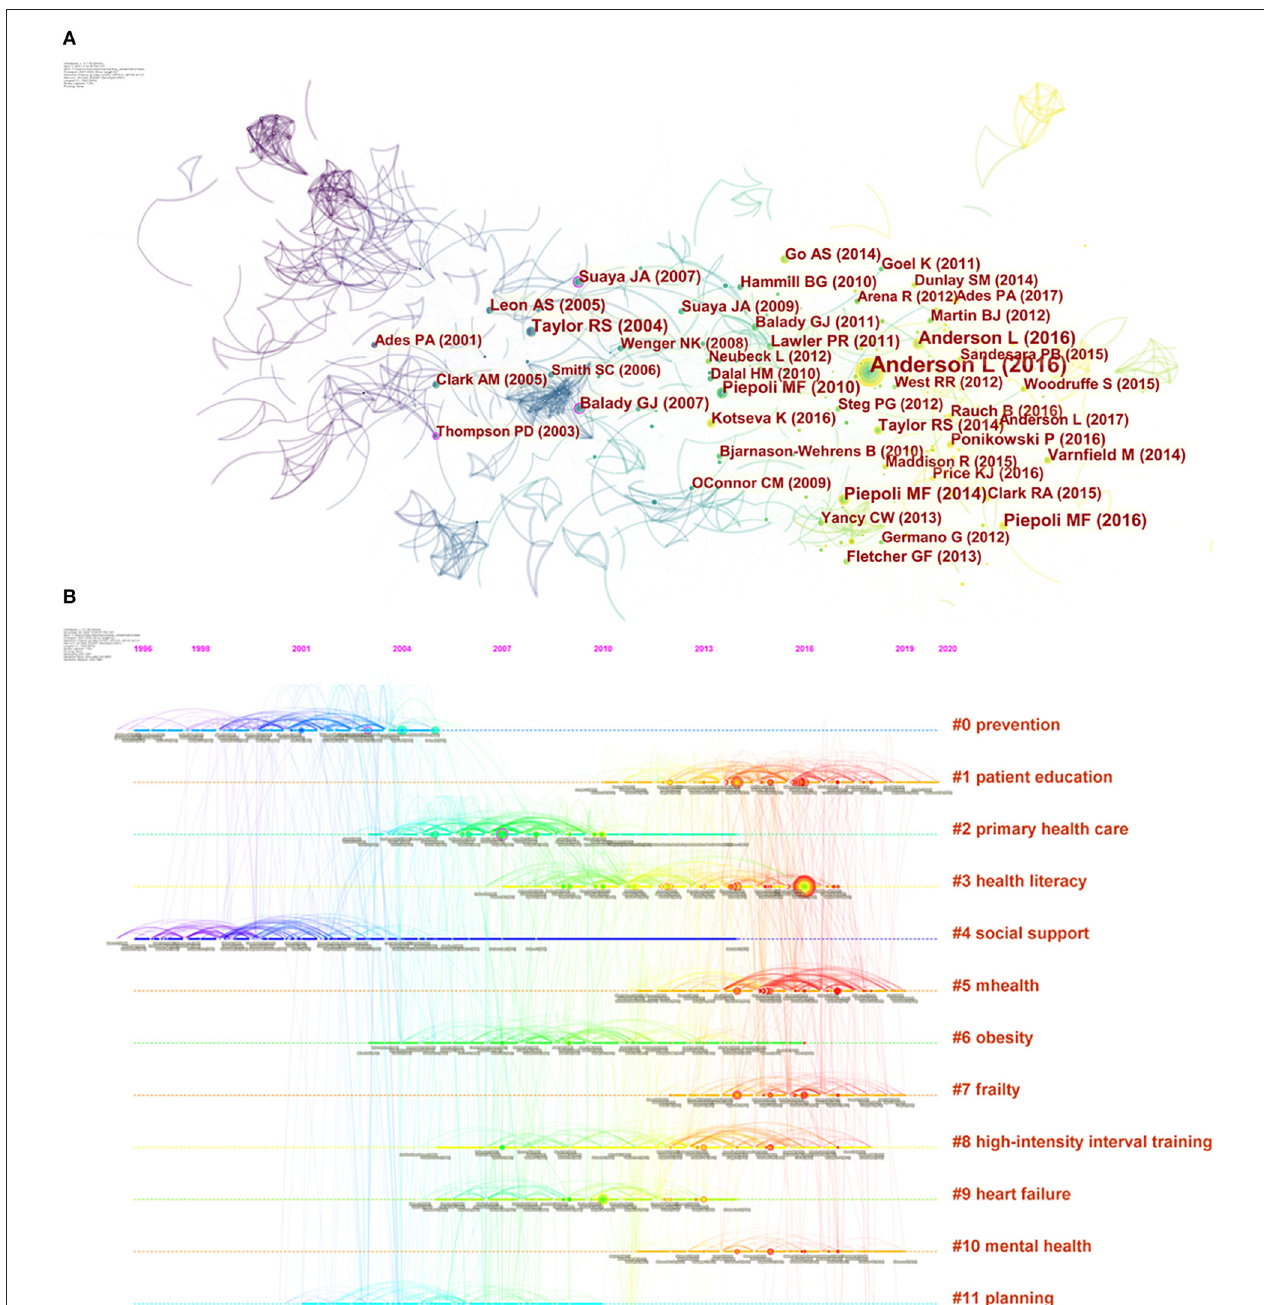
FIGURE 5 | Co-citation network and timeline view of references cited by publications about cardiac rehabilitation (CR) and related research. (A) References co-citation network. Circle node represents reference; the line between the nodes indicates the frequency of the two references being cited at the same time. The betweenness centrality of the nodes with purple circle is > 0.1. (B) Timeline view of references. Each horizontal line represents a cluster; the circular nodes on the line represent the top three most cited references in this time slice. The timeline is shown at the top of the figure , and the year corresponding to the node is its publication time. Link between nodes represents the co-citation